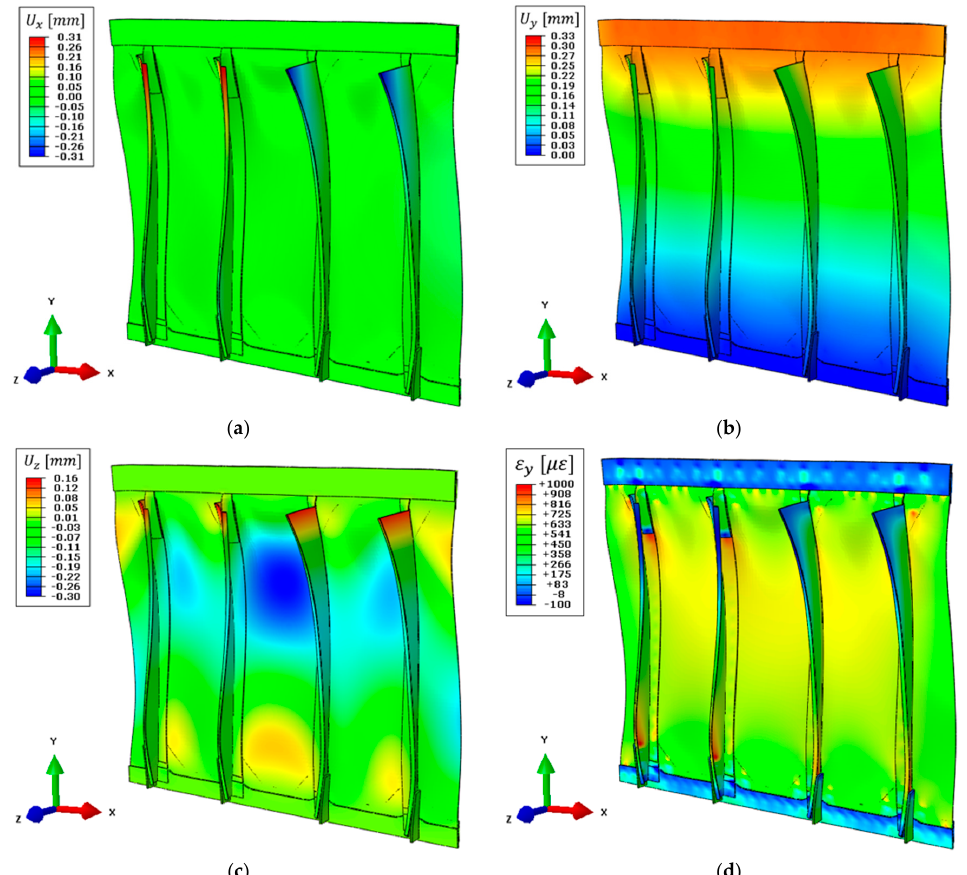
Figure 11. Complete iFEM model results with full definition of the input strain field, deformed shape with scale factor 100: ( a ) Displacement field on the x-direction, ( b ) displacement field on the y-direction, ( c ) displacement field on the z-direction, ( d ) strain field on the y-direction on the top side of the structure.